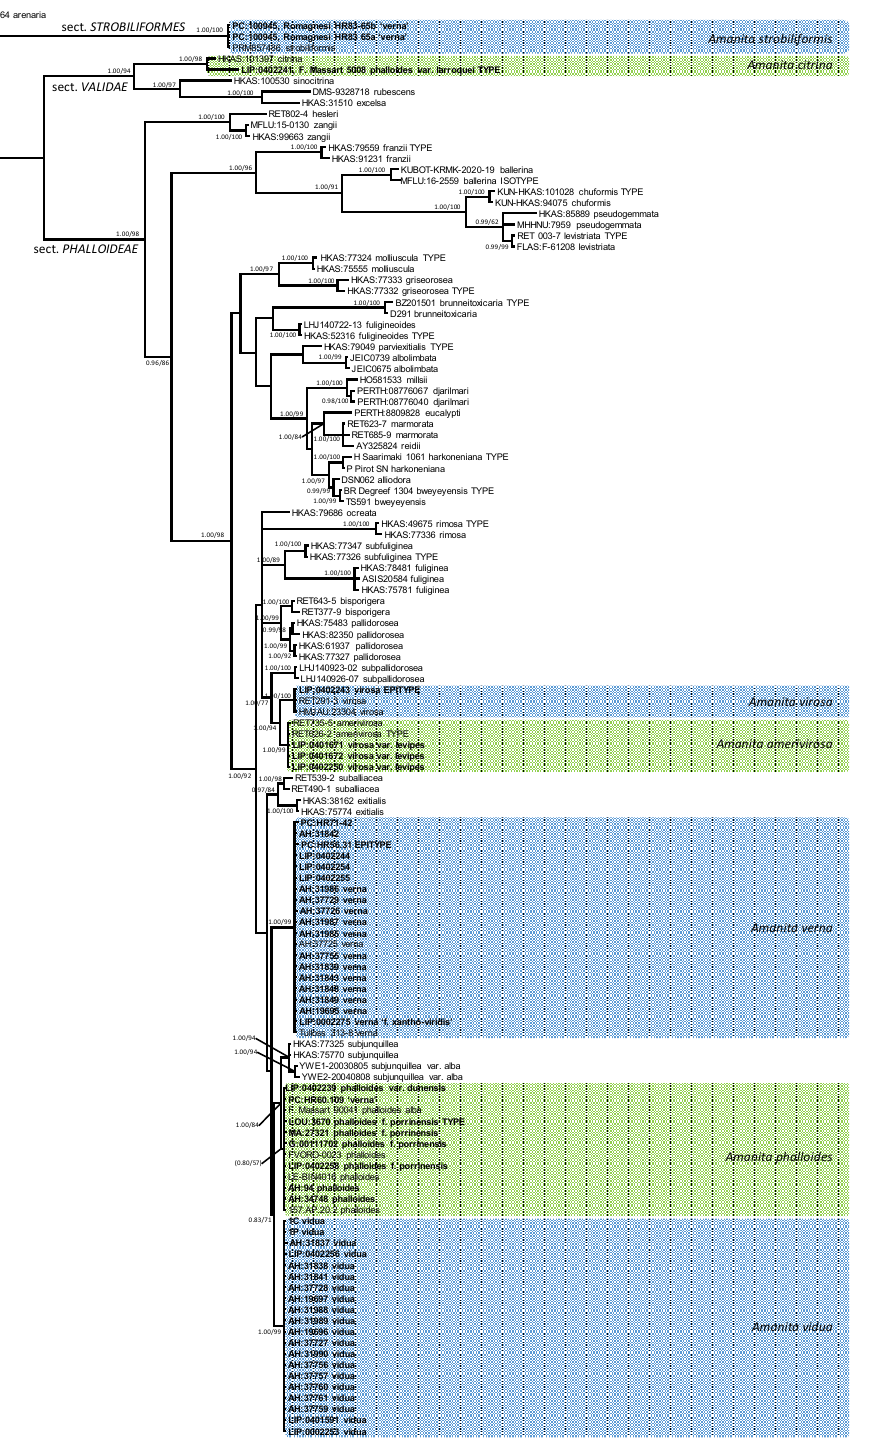
Figure 1. A 50% majority rule ITS rDNA-28S rDNA consensus phylogram of Amanita sect. Phalloideae and selected lineages of the neighboring sections Strobiliformes and Validae (with Amanita arenaria from sect. Arenaria [66] as outgroup) obtained using MrBayes from 7050 sampled trees. Nodes were annotated if they were supported by ≥ 0.95 Bayesian posterior probability (left) or ≥ 70% maximum likelihood bootstrap proportions (right). Non-significant support values are exceptionally represented in parentheses. Sequences newly generated in this study are in bold face.